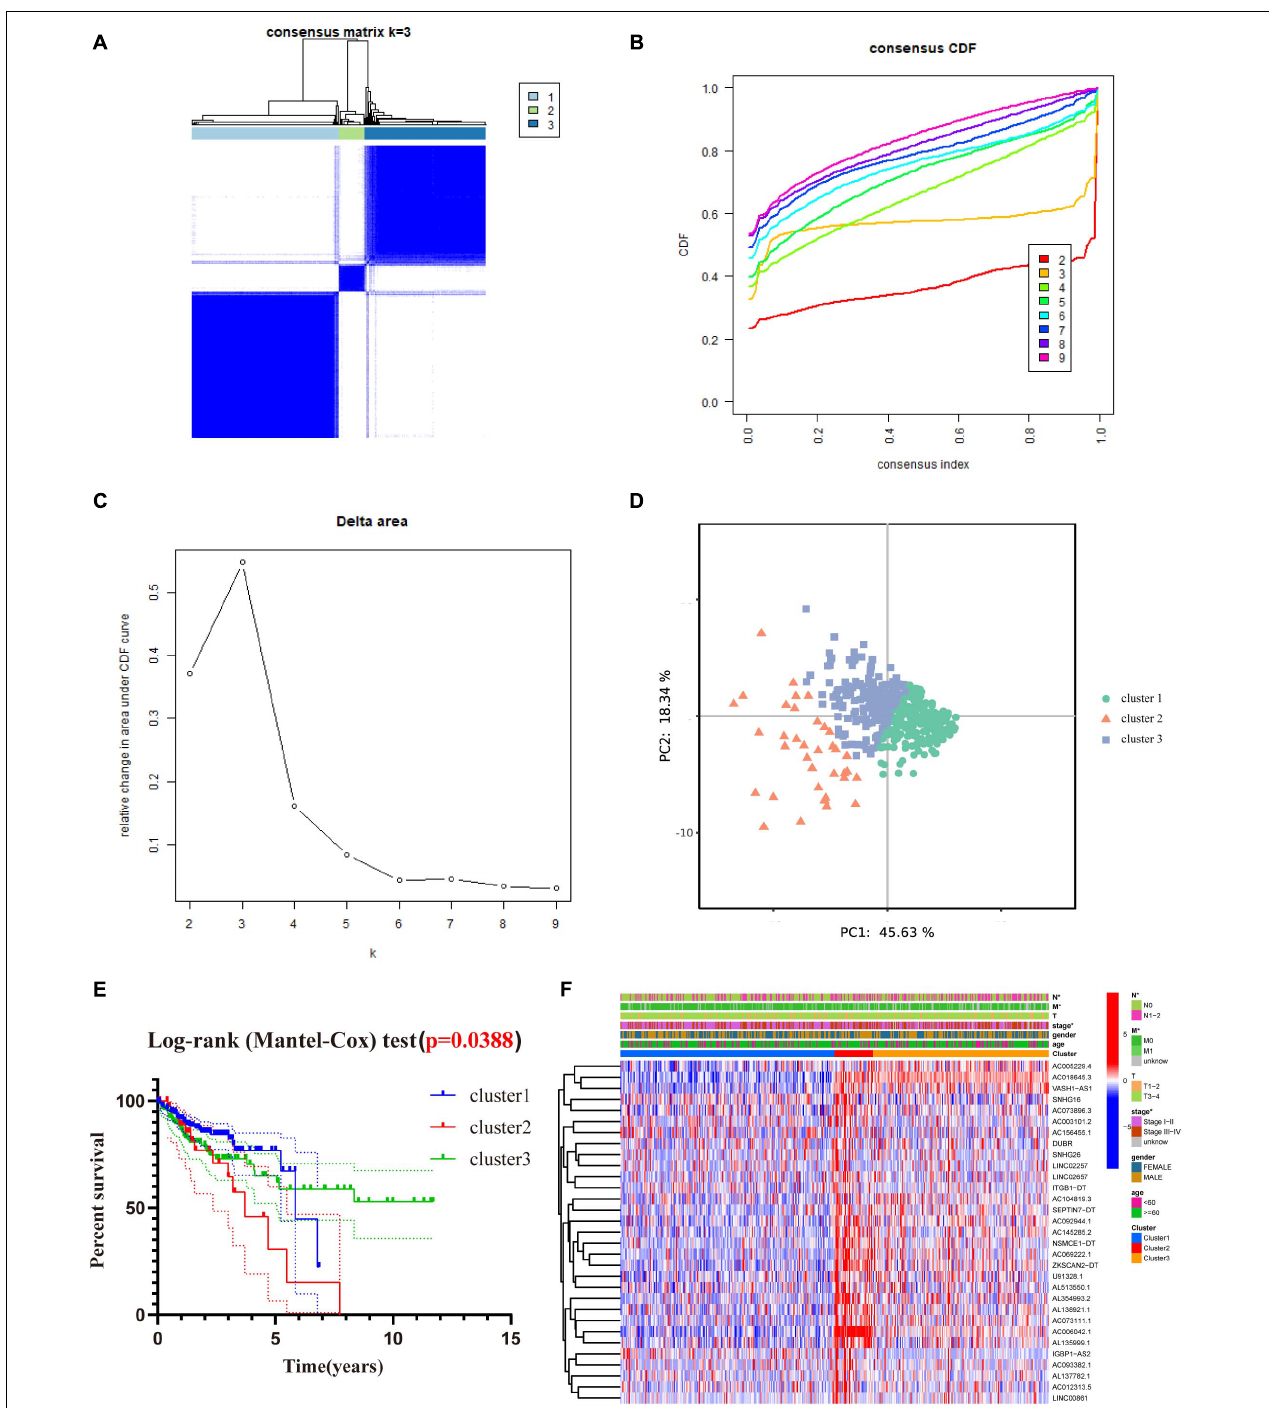
FIGURE 4 | Consensus clustering of the tumor cohort of TCGA-COAD based on 31 prognostic m6a-related lncRNAs. (A) Consensus clustering matrix for k = 3. (B) The empirical CDF plot for k = 2 through 9. (C) Relative change in area under the CDF curve for k = 2 through 9. (D) PCA shows that, when K = 3, it is possible to well distinguish COAD into three clusters based on the isoforms determined by the expression of prognostic m6A-related lncRNAs. (E) Kaplan–Meier curves of OS for three clusters in COAD. (F) Heat map of the association between the m6a-related lncRNAs from three clusters and clinicopathological features in the TCGA data set (* P <